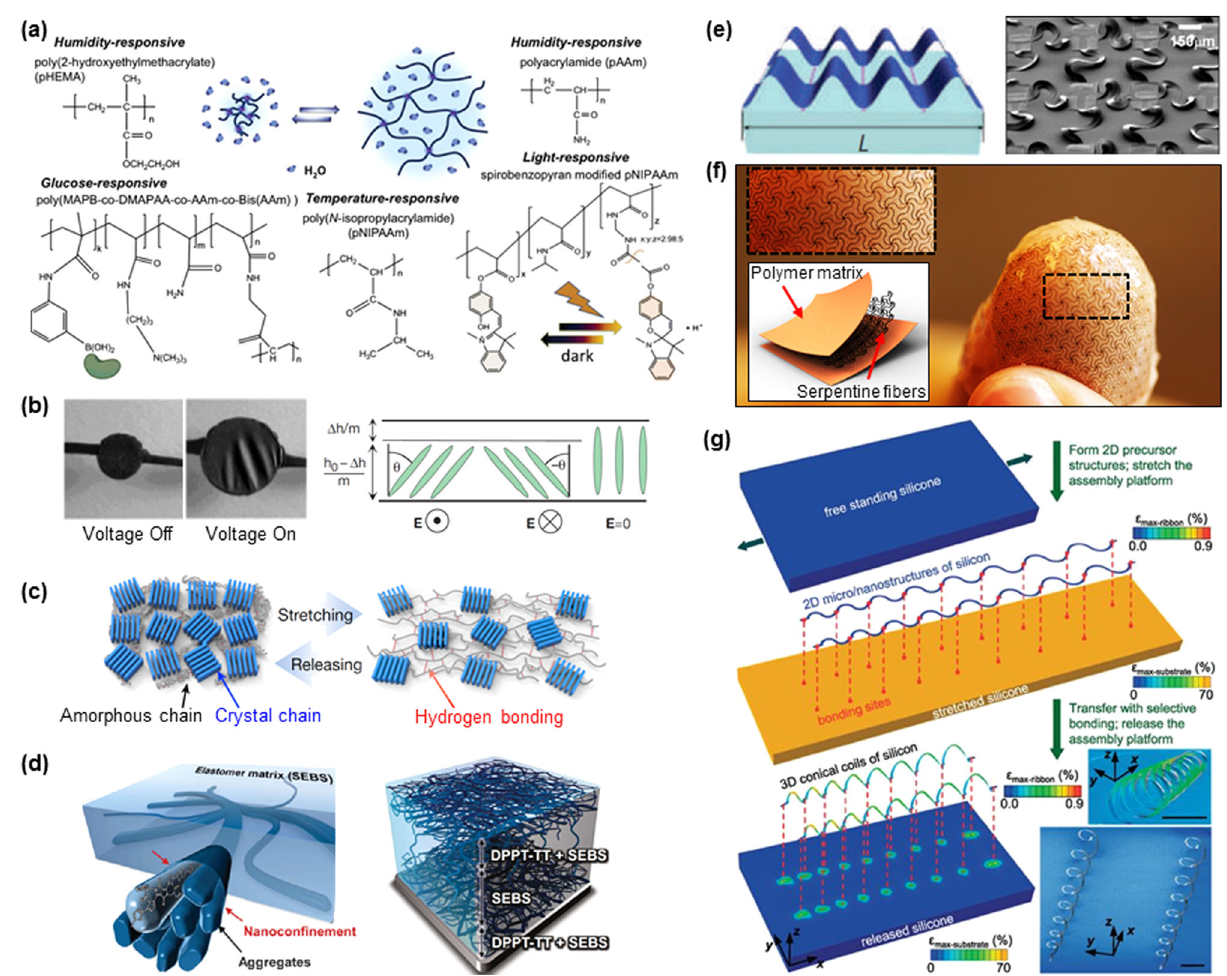
Fig. 1 Stretchable materials and recon fi gurable structures. a A variety of hydrogels responsive to different stimuli that include humidity, temperature, light, and glucose. Reprinted with permission from ref. 12. b Electrostatic attraction between electrodes generates an electrostatic pressure on the fi lm of dielectric elastomer, leading to a contraction in the thickness and an expansion in area. Electrically activated liquid-crystal elastomers lose the nematic order and relax to their coiled conformation, resulting a thickness reduction. Reprinted with permissions from refs. 17 and 18. c Introducing non-conjugated moieties directly in the polymer backbone as hydrogen-bonding units enhances stretchability in conjugated polymers, due to the effective energy dissipation through breakage of bonds. Almost full recovery of the carrier mobility has been demonstrated after the solvent and thermal healing treatment. Reprinted with permissions from ref. 19. d Embedding nanoscale networks of semiconducting polymer achieves high stretchability from a reduced modulus and delayed onset crack propagation. Both the decreased glass transition temperature and suppressing crystallization contributed to the reduced modulus. Additional layer of soft elastomer sandwiched between two composite layers with nanocon fi nement further suppresses crystallization and prevents crack propagation. Reprinted with permissions from ref. 20. e Selected bonding of thin ribbons to a pre-stretched substrate, followed by a release of the pre-strain, results in a wavy geometry in the thin ribbon (left). Functional components that are connected by wavy metallic interconnects in an “ island-bridge ” layout on a soft polymer are capable of deforming into an arbitrary shape (right). Reprinted with permission from refs. 22 and 24. f Schematic illustration of an arti fi cial skin construct that exploits a two-dimensional network of photolithographically de fi ned polyimide fi laments embedded in the middle of a soft polymer matrix. Adapted with permission from ref. 28. g Mechanical assembly of 3D single-crystal Si conical helices from 2D fi lamentary serpentine ribbons bonded at selected points (red dots) to a pre-stretched silicone elastomer. Release of the pre-stretch results in an out-of-plane motion in the Si ribbon to form 3D structures. Lower right shows SEM images of an experiment. Reprinted with permission from ref. fi elds (e.g., dielectric elastomer, 17 liquid-crystal elastomer 18 ) also appear as emerging feasible materials to mimic muscle move- ments 13 (Fig. 1b). Intrinsically stretchable semiconducting poly- mers are of particular interest, due to their essential role in thin- fi lm fi eld-effect transistors (FETs). Introducing hydrogen bonding